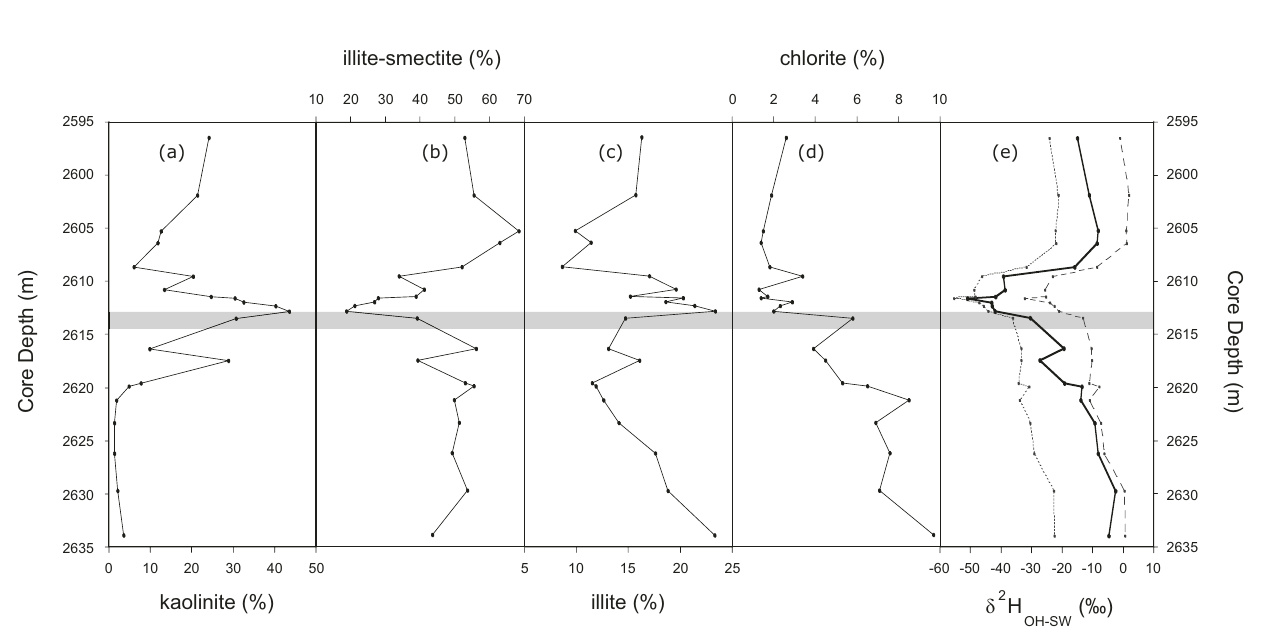
Fig. 3 | Comparison of the relative percentage of the component clays (note that panels use different scales) and reconstructed clay mineral formation source water versus depth in the core from well 22/10a-4. The onset of the Carbon Isotope Excursion (CIE) is shown by the light grey bar. a kaolinite; b illite- smectite; c illite and d chlorite in the <4 μ m size fraction from well 22/10a-4 33 and e the reconstructed clay mineral (neo)formation source water δ 2 H ( δ 2 H OH-SW ).